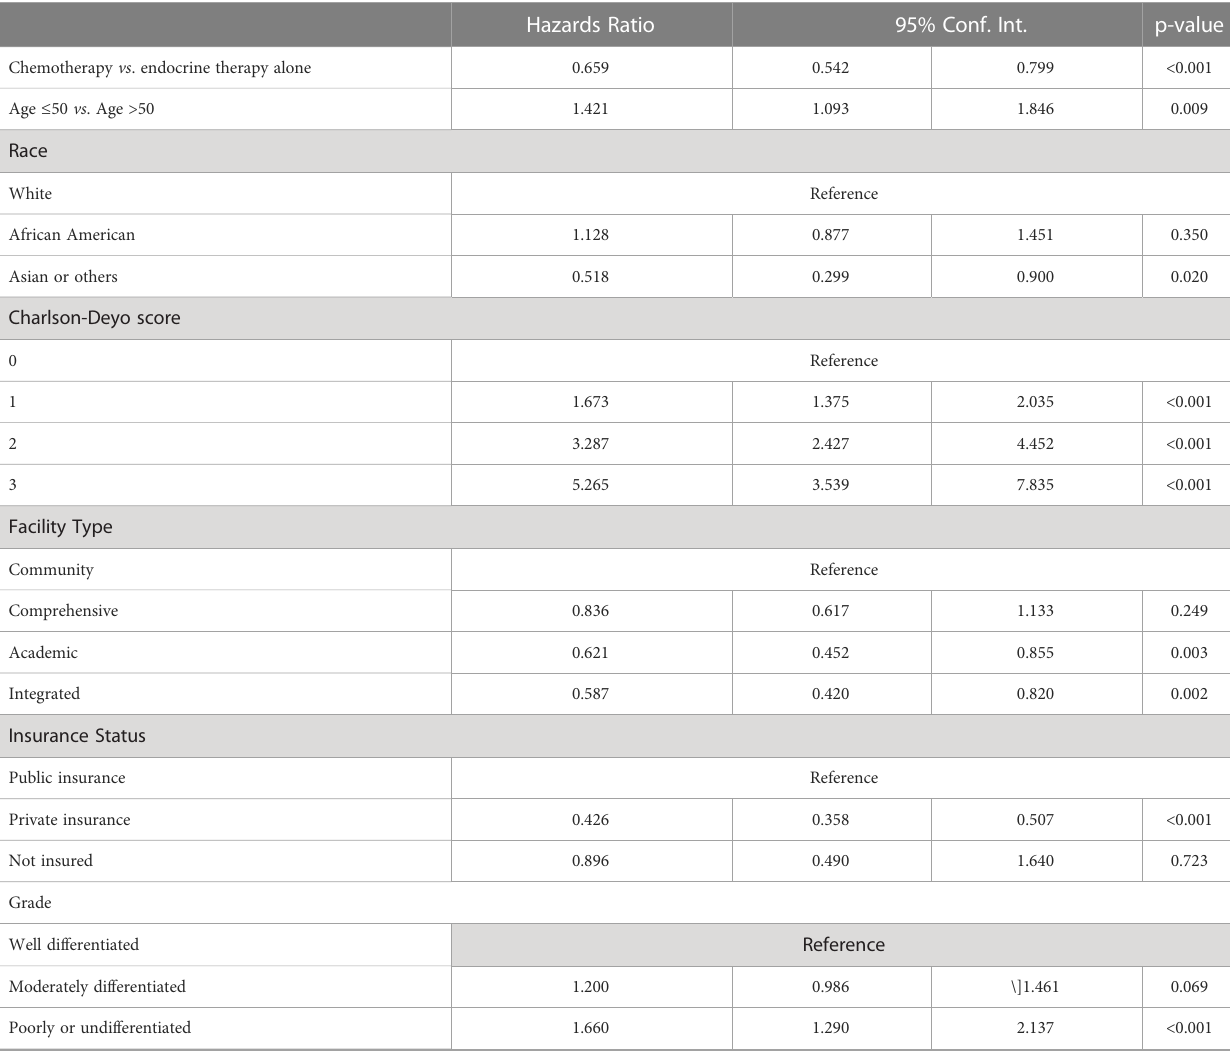
Hazards Ratio 95% Conf. Int. p-value 0.659 0.542 0.799 <0.001